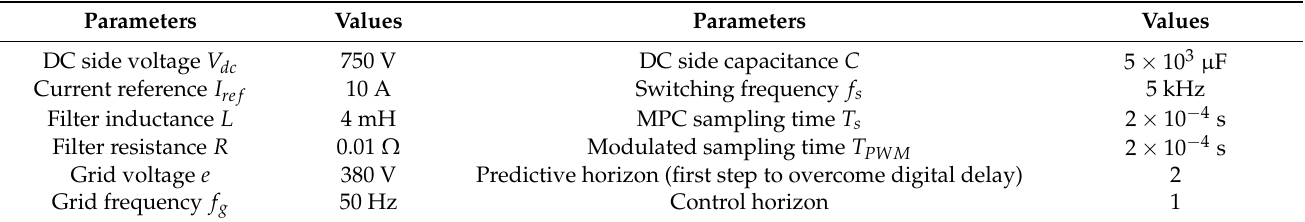
Table 5. Simulation Parameters.